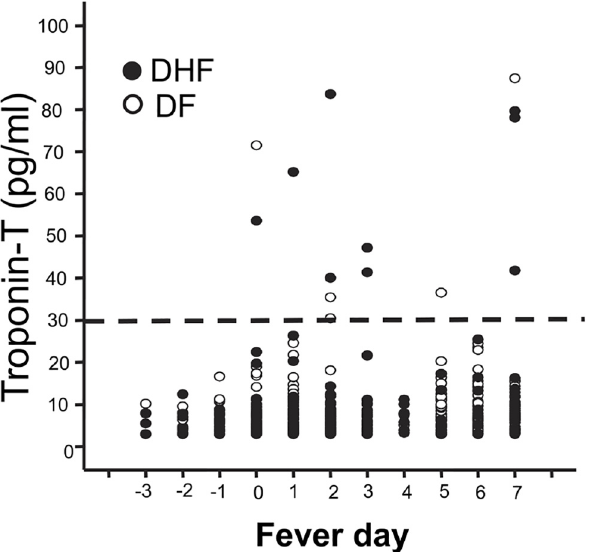
Fig 5. Plasma troponin-T levels in individual DF (white circles) or DHF cases (black circles) during the course of the illness. The horizontal line indicates a cut-off for an abnormal value at 30 pg/ml.